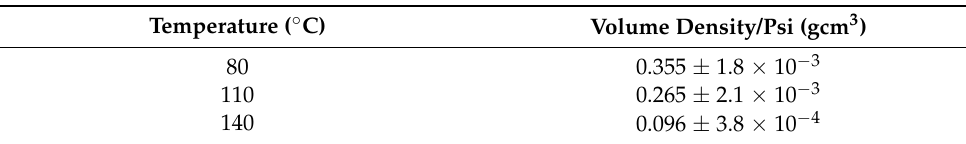
Table 1. The volume density of the foams foaming at 16 MPa and different temperatures [47]. Reproduced with permission from Elsevier.